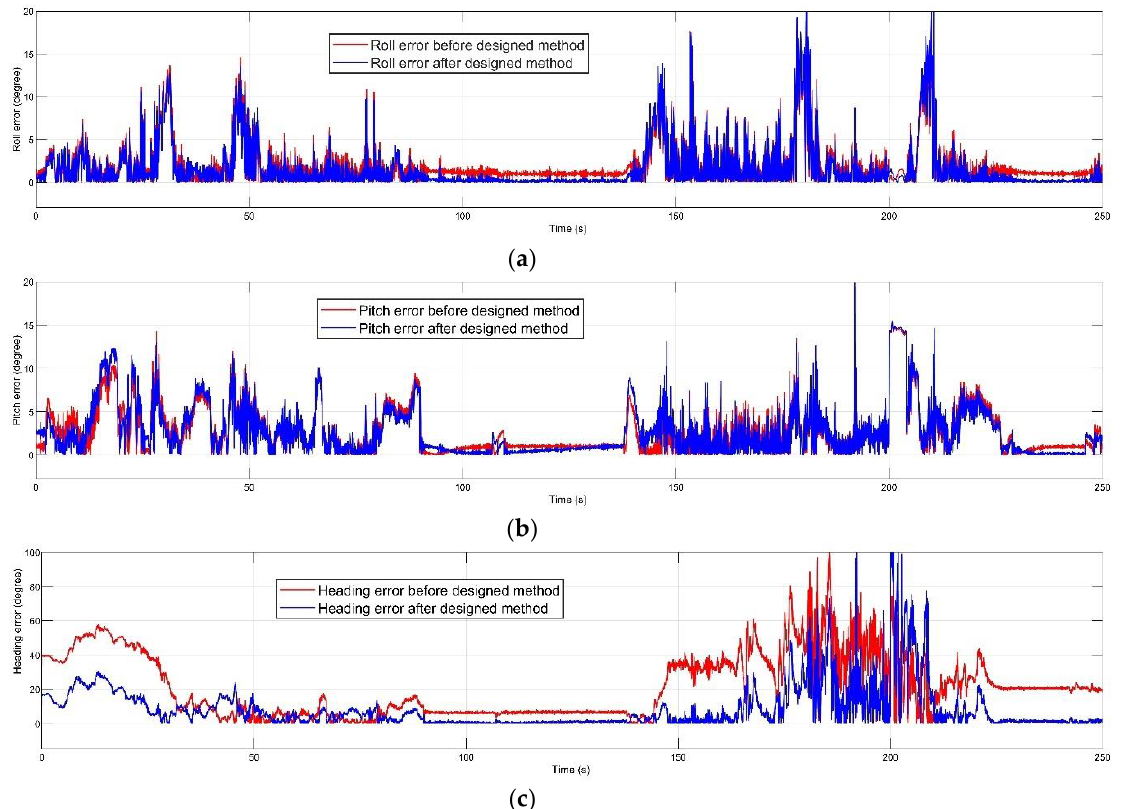
Figure 9. Absolute attitude error before and after performing the method for each orientation channel: ( a ) roll; ( b ) pitch; ( c ) heading.